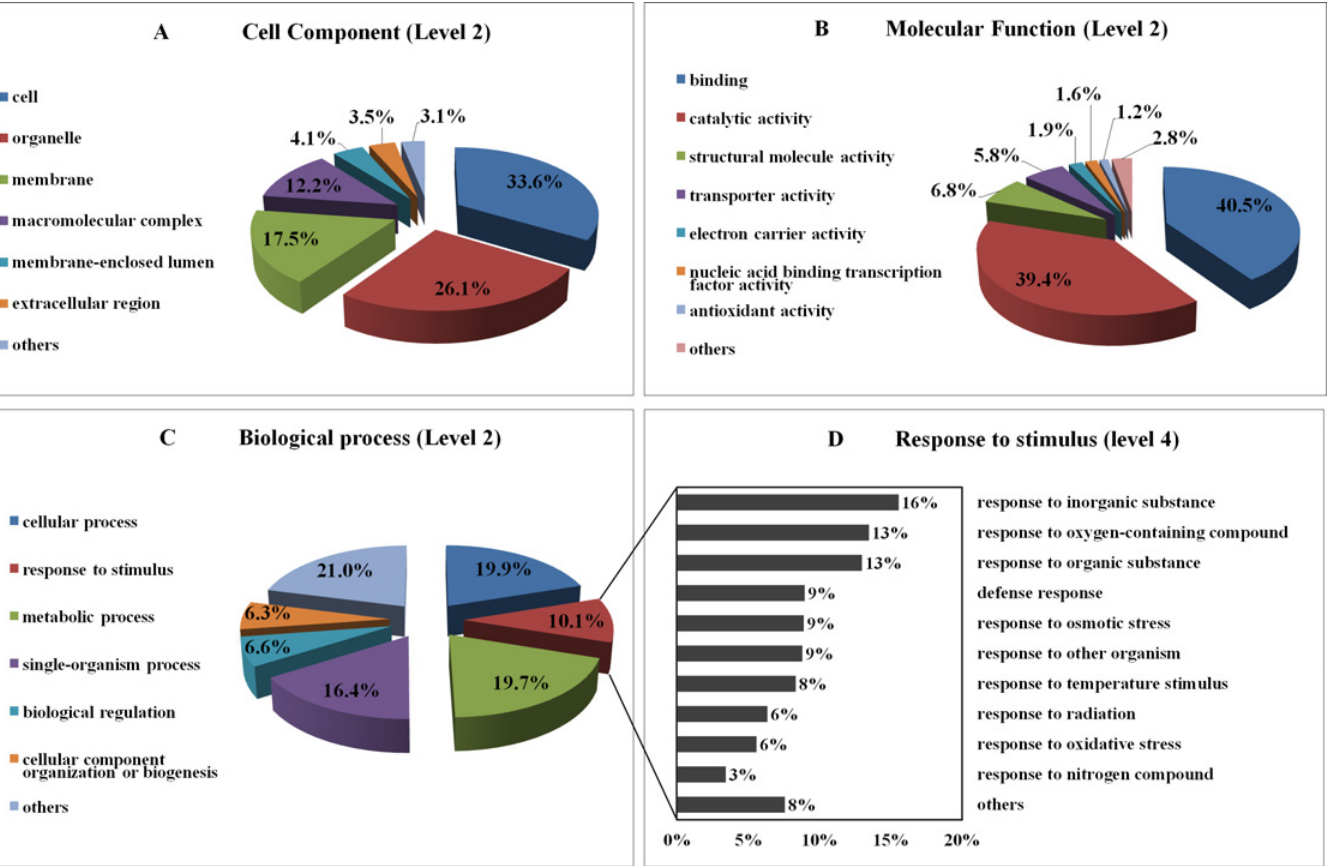
Fig 4. Functional classifications of 2,678 uniESTs that were assigned GO terms. Tortadiagrams represented the second-level GO terms for three categories: cellular component (A), molecular function (B) and biological process (C). The histogram represents the GO term ‘ Response to stimulus ’ at level 4